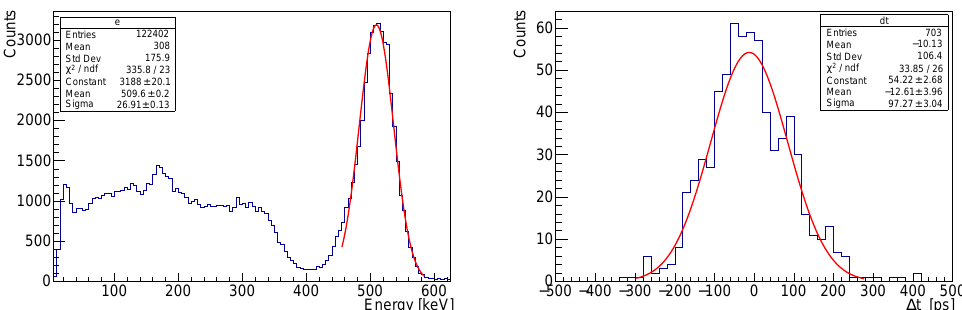
Figure 3. The 511 keV gamma spectrum obtained by 3 × 3 × 3 mm 3 LYSO crystal with KETEK SiPM at 4 V overvoltage ( left ). Coincidence time spectrum of annihilation gammas from 22 Na, detected by two 3 × 3 × 3 mm 3 LYSO crystals with KETEK SiPM at 4V overvoltage ( right ). Events with energy within 511 keV ± 1 σ were selected.